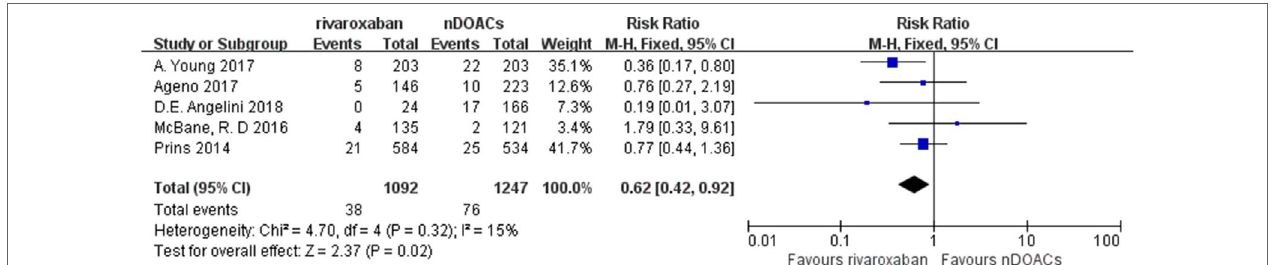
FIGURE 4 | Rivaroxaban recurrent VTE forest